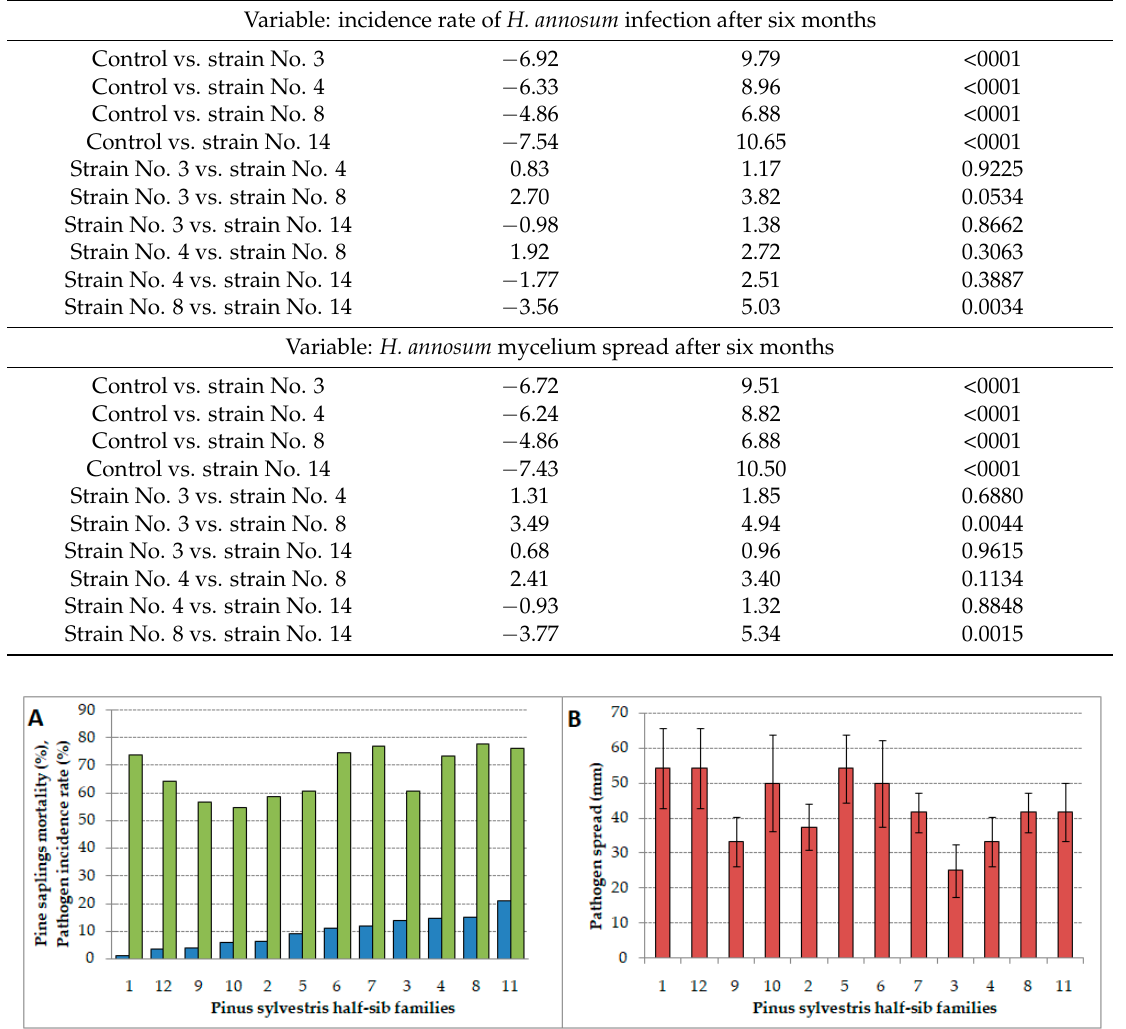
Table 1. Pairwise comparison of H. annosum strains in between and with control (sample size n = 36). Pairs of Treatments for Comparison Wilcoxon Z DSCF Value Pr > DSCF Variable: incidence rate of H. annosum infection after six months Control vs. strain No. 3 − 6.92 Control vs. strain No. 4